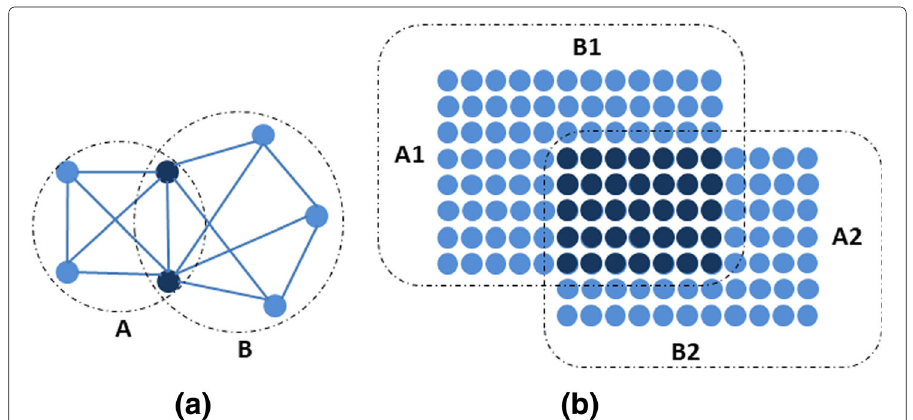
Fig. 3 a Simple cluster overlapping coefficient b bicluster overlapping